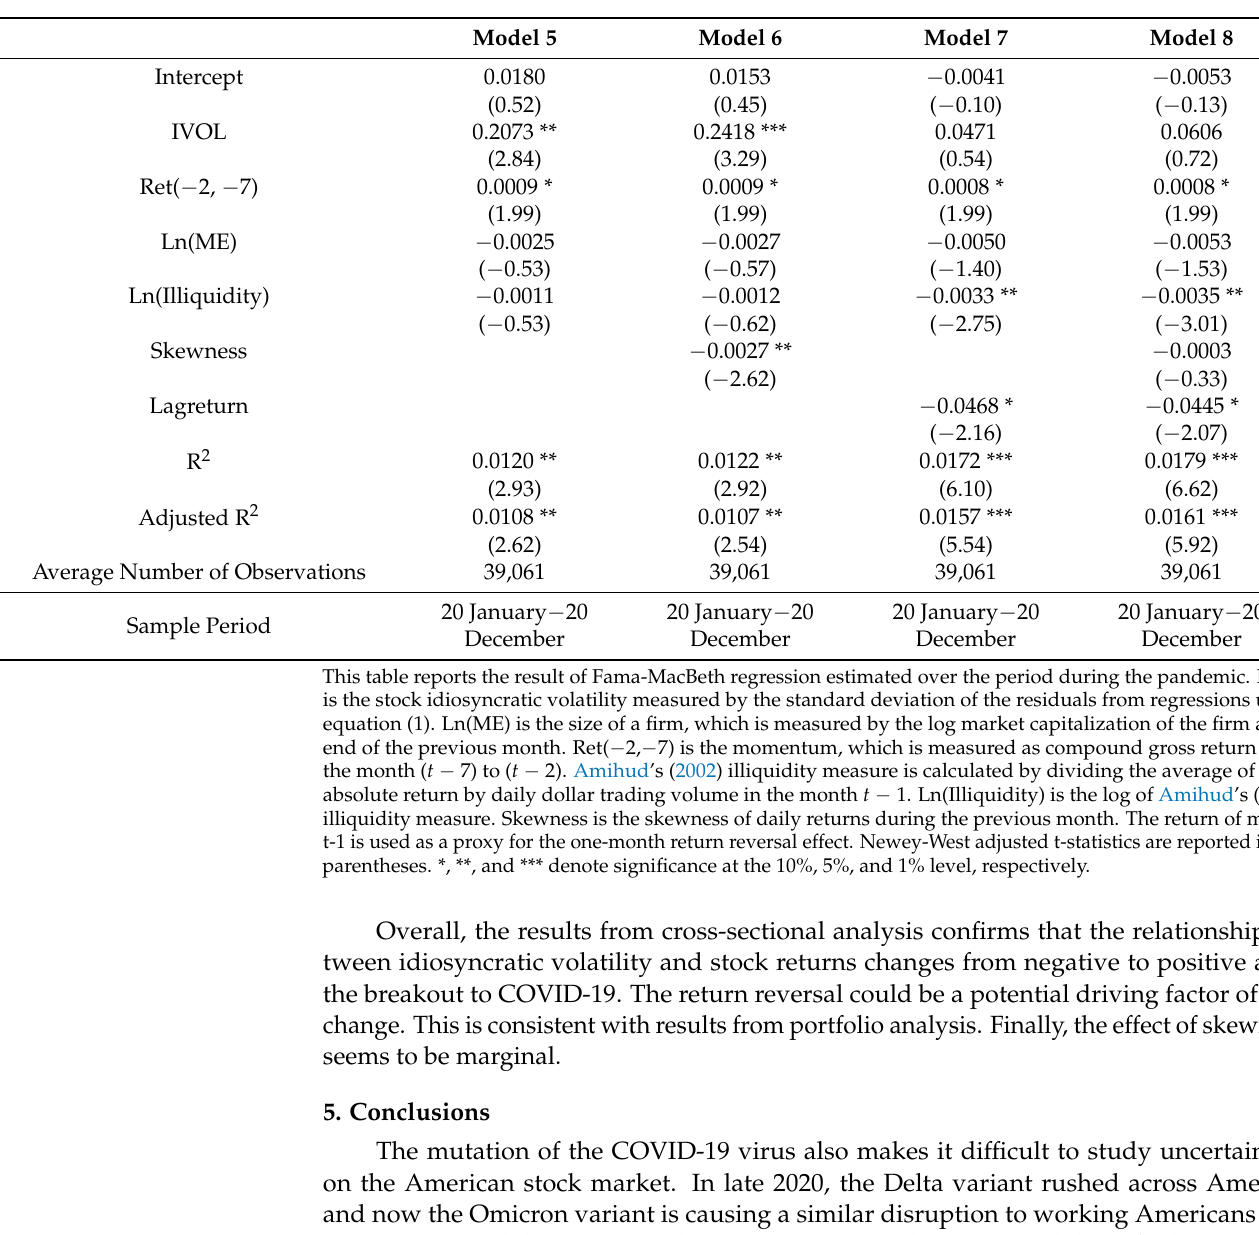
Table 4. Cross-sectional analysis during the